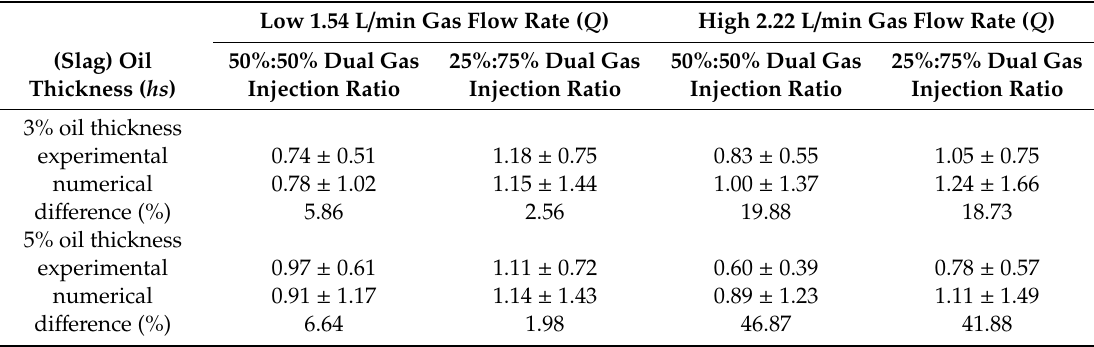
Table 4. Mean values of turbulent kinetic energy k (× 10 − 3 m 2 /s 2 ) for the experimental and numerical model along the longitudinal plane (symmetry plane) for the eight cases presented in this study.